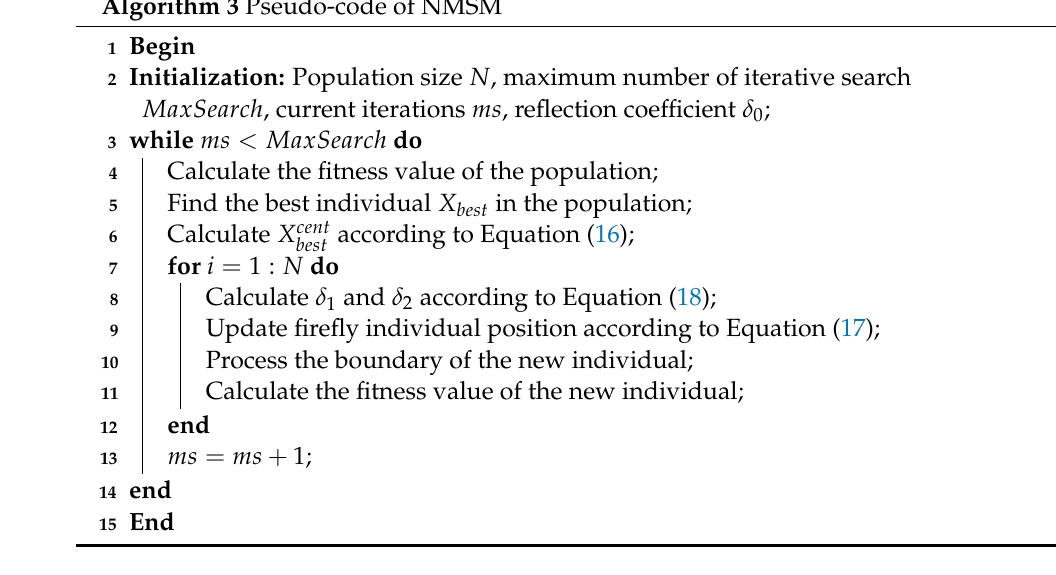
Algorithm 4 Pseudo-code of